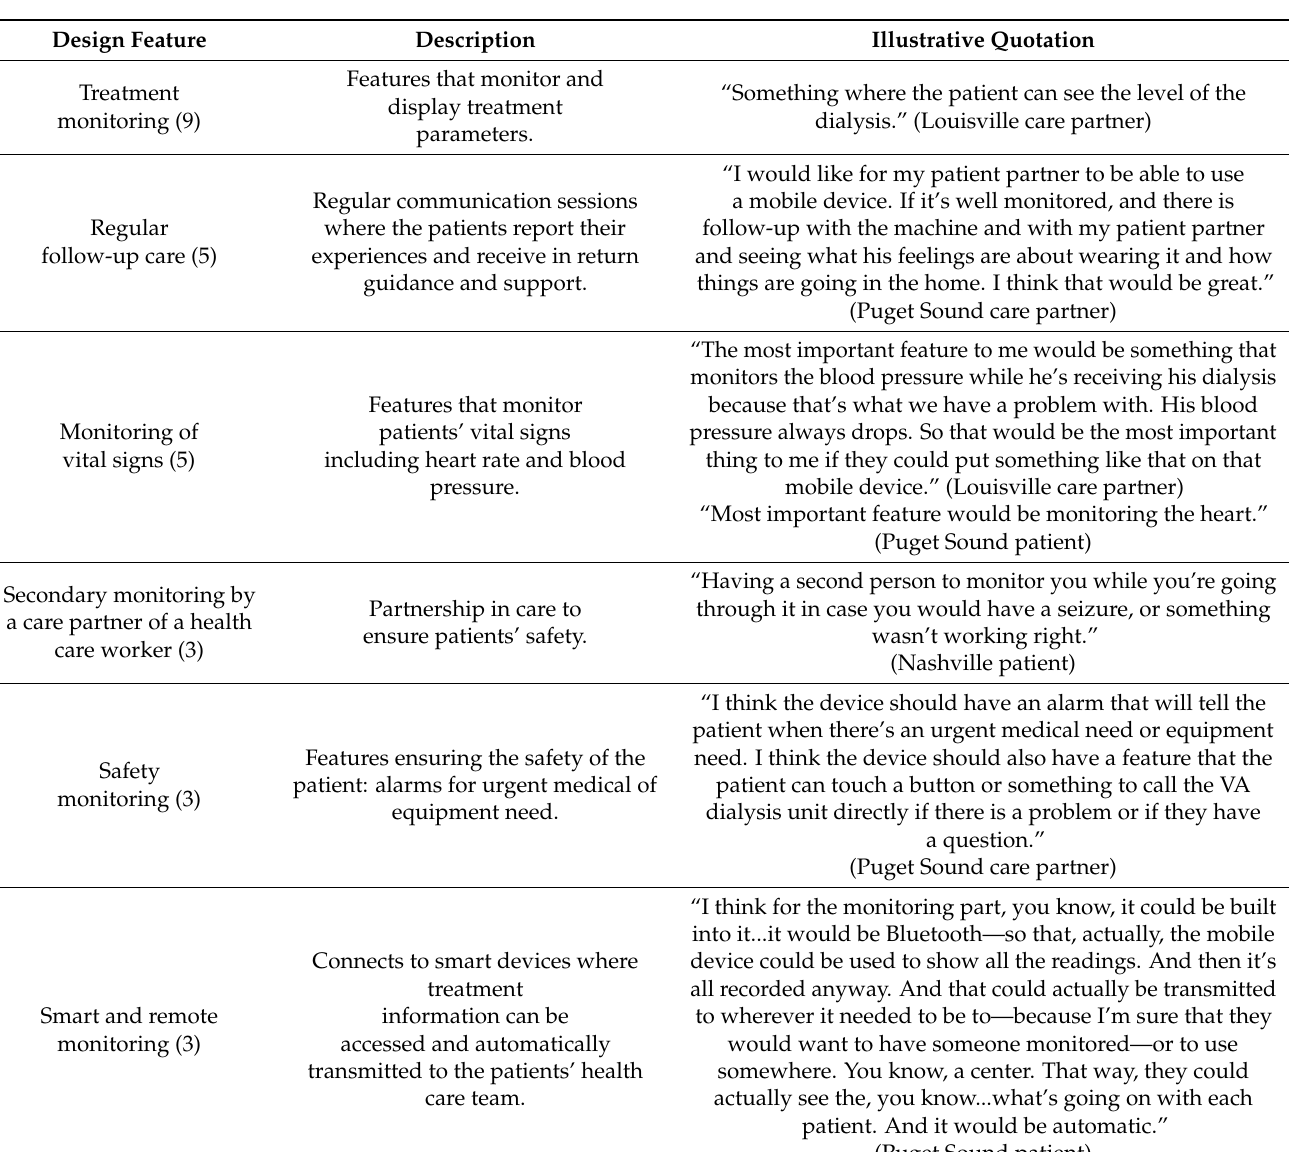
Table 2. Design features along with exemplary quotations from patients and care partners related to mobile dialysis monitoring. The number in parentheses next to each category indicates the number of related